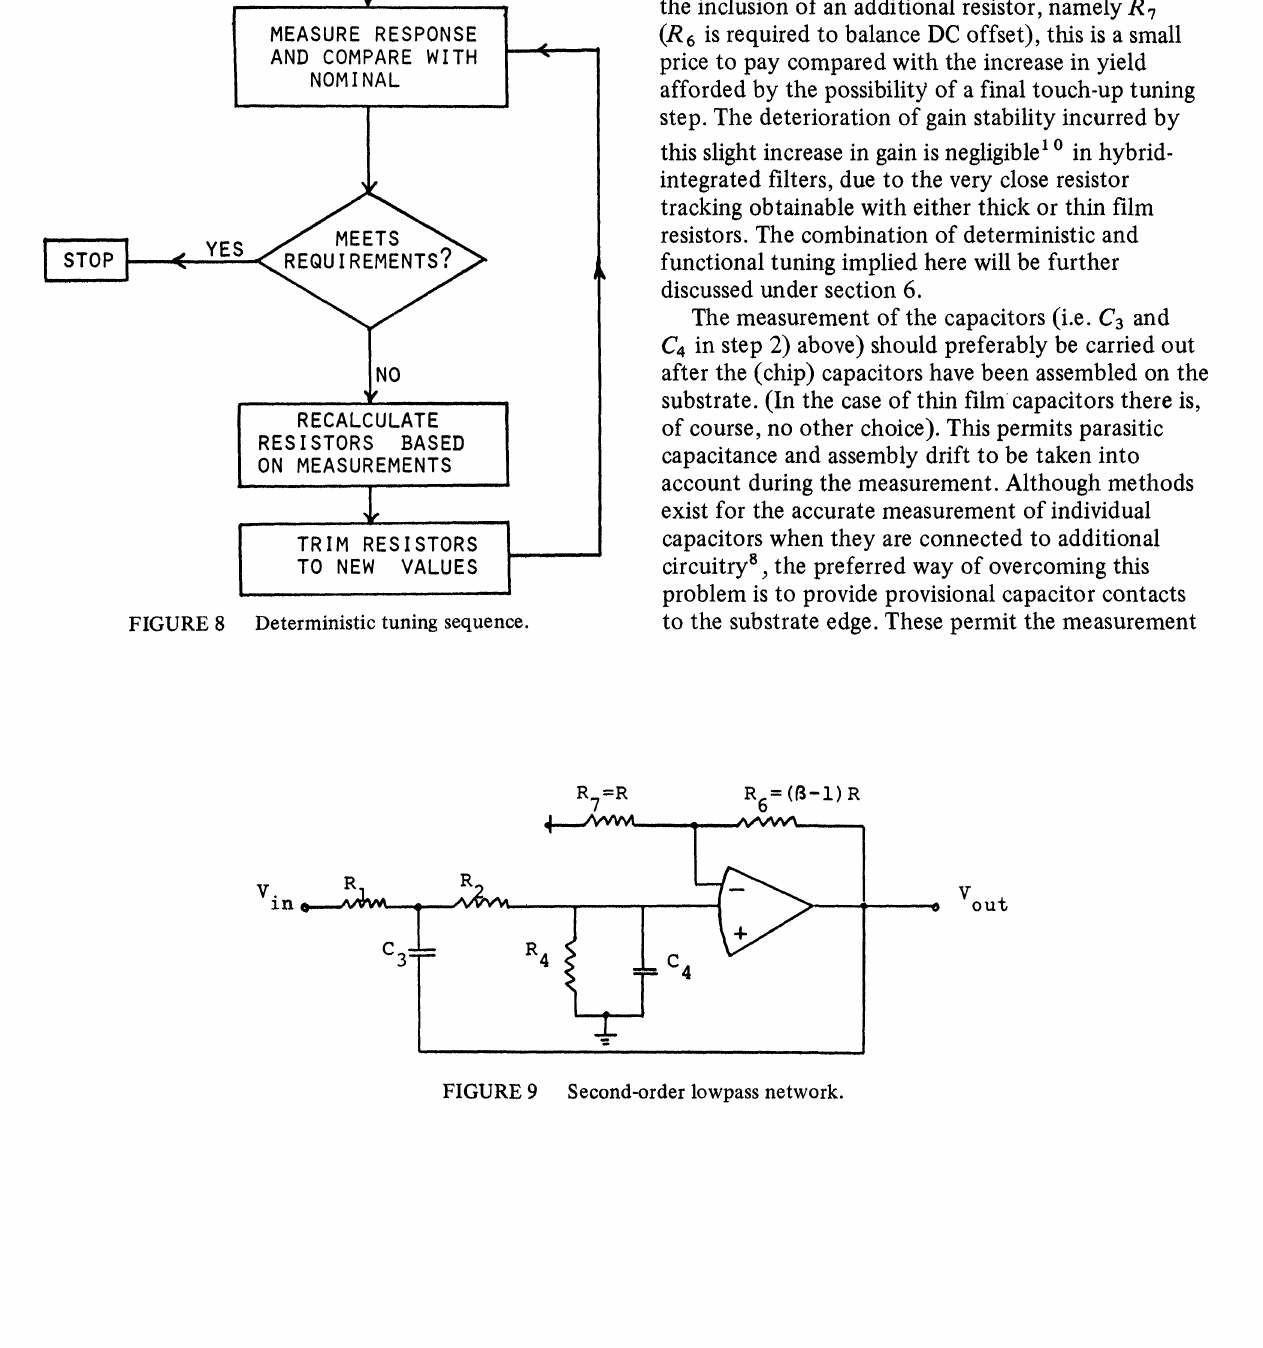
FIGURE 9 Second-order lowpass